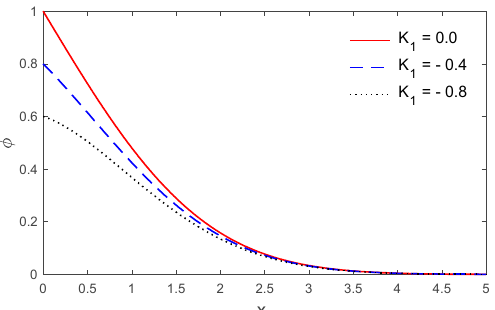
Figure 1. Variations of temperature with respect to the distance for various values of (cid:1837) (cid:2869) .